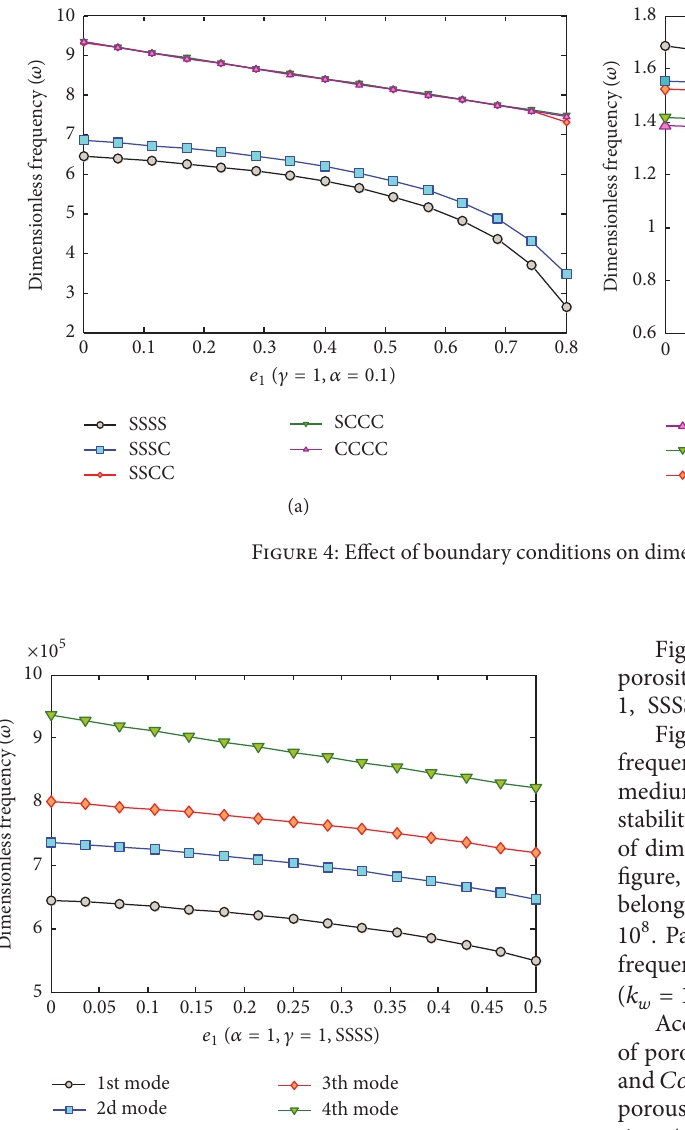
Figure 5: Variation of dimensionless natural frequency versus porosity for four primary